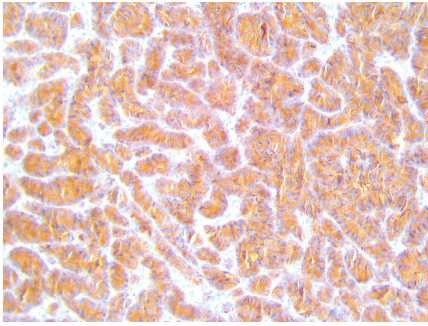
Figure 3: Positivity of the tumor to the immunohistochemical staining for